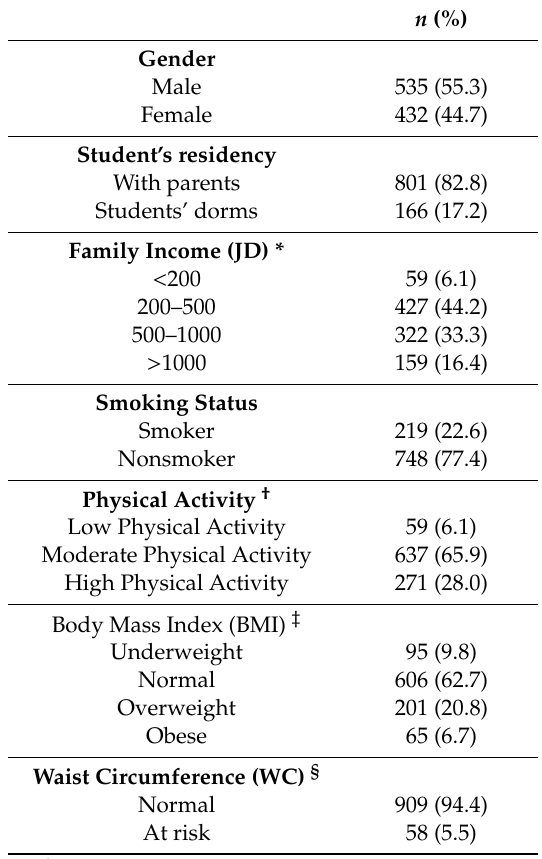
Table 1. Sample socio-demographic and anthropometric characteristics ( n =